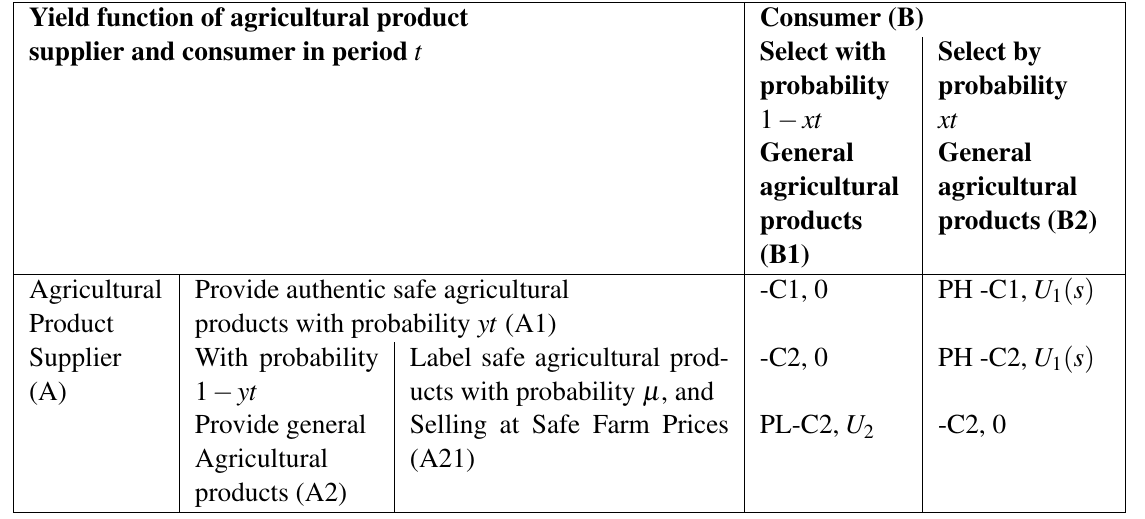
Table 1 Possible benefits of different strategic choices between suppliers and